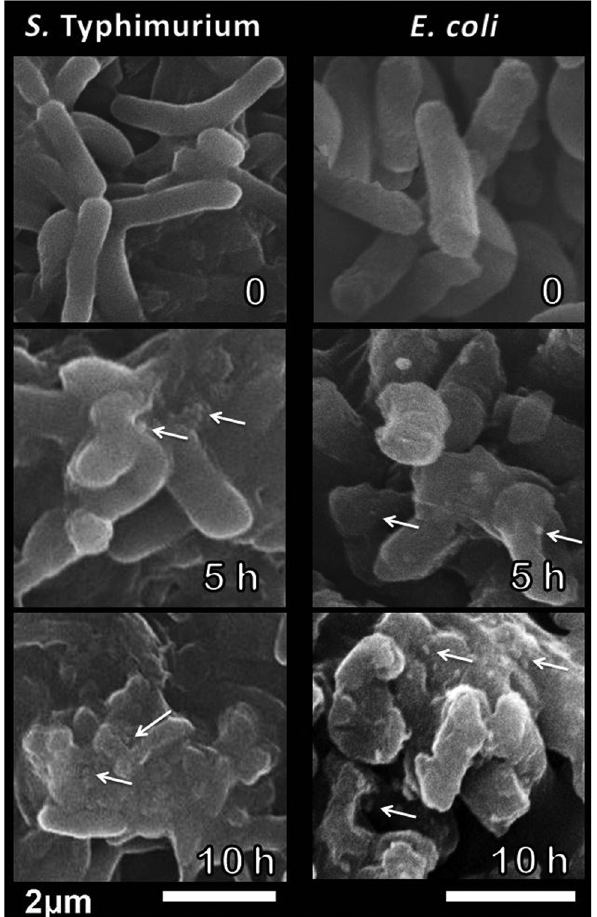
Figure 3: SEM micrographs of exposed S. typhimurium and E. coli to phytosynthesized Se - NPs with costus extract after 0, 5 and 10 h of treatment. Arrows indicate some attached Se - NPs to compromised bacterial